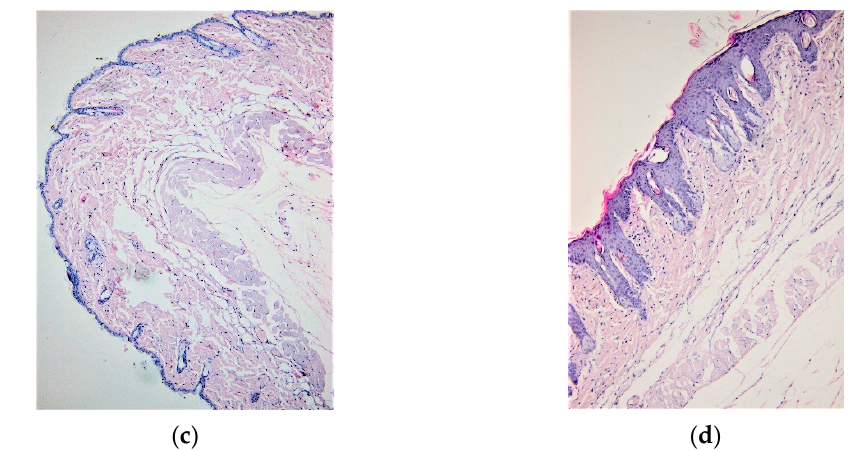
Figure 1. Evolution of in vivo parameters and histopathological assessment of dorsal skin samples. ( a ) In vivo measurements scores for erythema (0 ± 0; 1.1 ± 0.2; 2.1 ± 0.4; 2.6 ± 0.4; 3.3 ± 0.4; 3.4 ± 0.4; 2.8 ± 0.4), thickening (0 ± 0; 0.4 ± 0.6; 1.2 ± 0.4; 2 ± 0.4; 2.8 ± 0.4; 3.3 ± 0.4; 3.7 ± 0.4) and skin scaling (0 ± 0; 0 ± 0; 1.1 ± 0.3; 1.6 ± 0.4; 2.6 ± 0.4; 3.2 ± 0.5; 3.5 ± 0.3) scores; ( b ) PASI scores (0 ± 0; 1.5 ± 0.6; 4.4 ± 0.6; 6.2 ± 0.8; 8.7 ± 0.6; 8.7 ± 0.6; 9.9 ± 0.7). The results are presented as mean score ± SD; n = 28 (n = number of mice; D = day); ( c ) H&E staining of the back skin samples provided from normal mouse (control group); ( d ) H&E staining of the back skin samples provided from IMQ-induced mouse (Ps group). IMQ-based cream induces hyperkeratosis, parakeratosis, acanthosis and elongation of rete ridges.